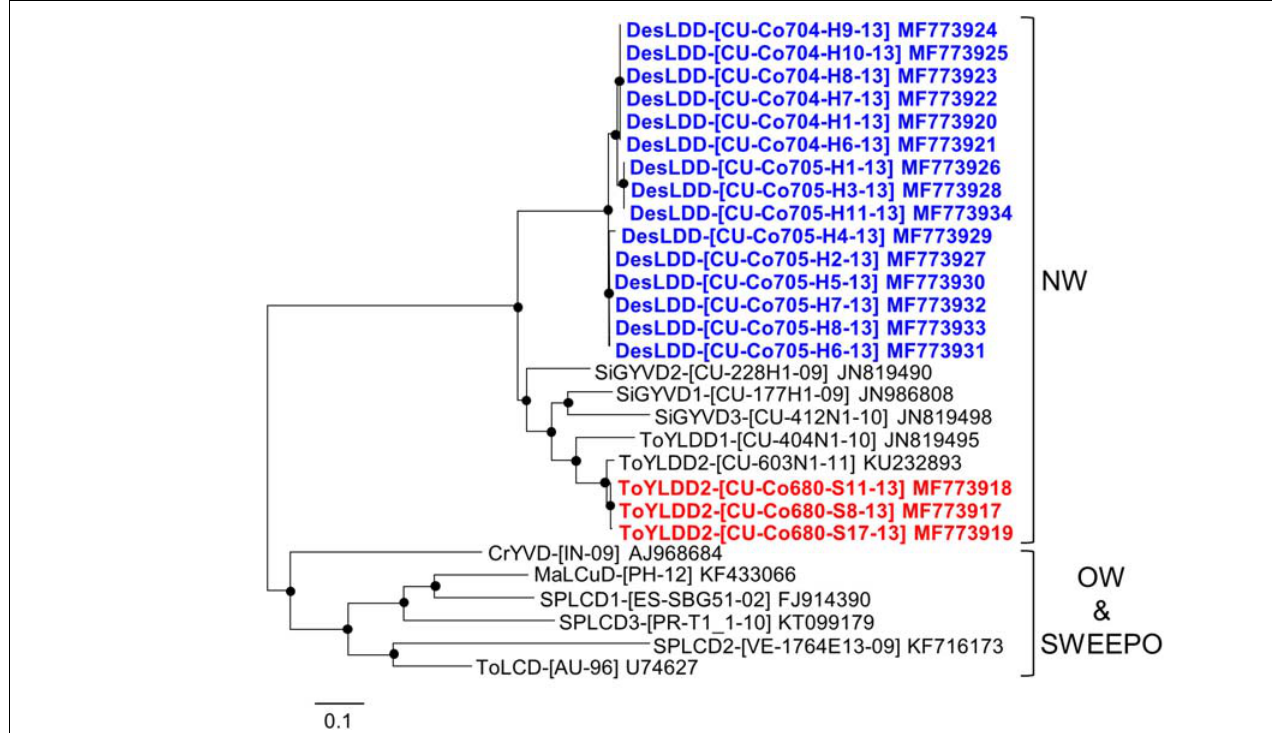
FIGURE 6 | Phylogenetic tree illustrating the relationships of Desmodium leaf distortion deltasatellite (DesLDD) (bold in blue) and tomato yellow leaf distortion deltasatellite 2 (ToYLDD2) (bold in red) isolates obtained in this work with representative isolates of other deltasatellite species. The tree was constructed by the maximum-likelihood method (1000 replicates) with the MEGA 7 program using the best fit model, T92 + G. CrYVD, Croton yellow vein deltasatellite; MaLCuD, Malvastrum leaf curl deltasatellite; SiGYVD1, Sida golden yellow vein deltasatellite 1; SiGYVD2, Sida golden yellow vein deltasatellite 2; SiGYVD3, Sida golden yellow vein deltasatellite 3; SPLCD1, sweet potato leaf curl deltasatellite 1; SPLCD2, sweet potato leaf curl deltasatellite 2; SPLCD3, sweet potato leaf curl deltasatellite 3; ToLCD, tomato leaf curl deltasatellite; ToYLDD1, tomato yellow leaf distortion deltasatellite 1; ToYLDD2, tomato yellow leaf distortion deltasatellite 2. Major deltasatellite clusters associated with bipartite New World begomoviruses (NW) and monopartite Old World begomoviruses and sweepoviruses (OW and SWEEPO) are indicated. The bar below the tree indicates the number of nucleotide substitutions per site. Nodes with bootstrap values higher than 50% are marked with filled circles.